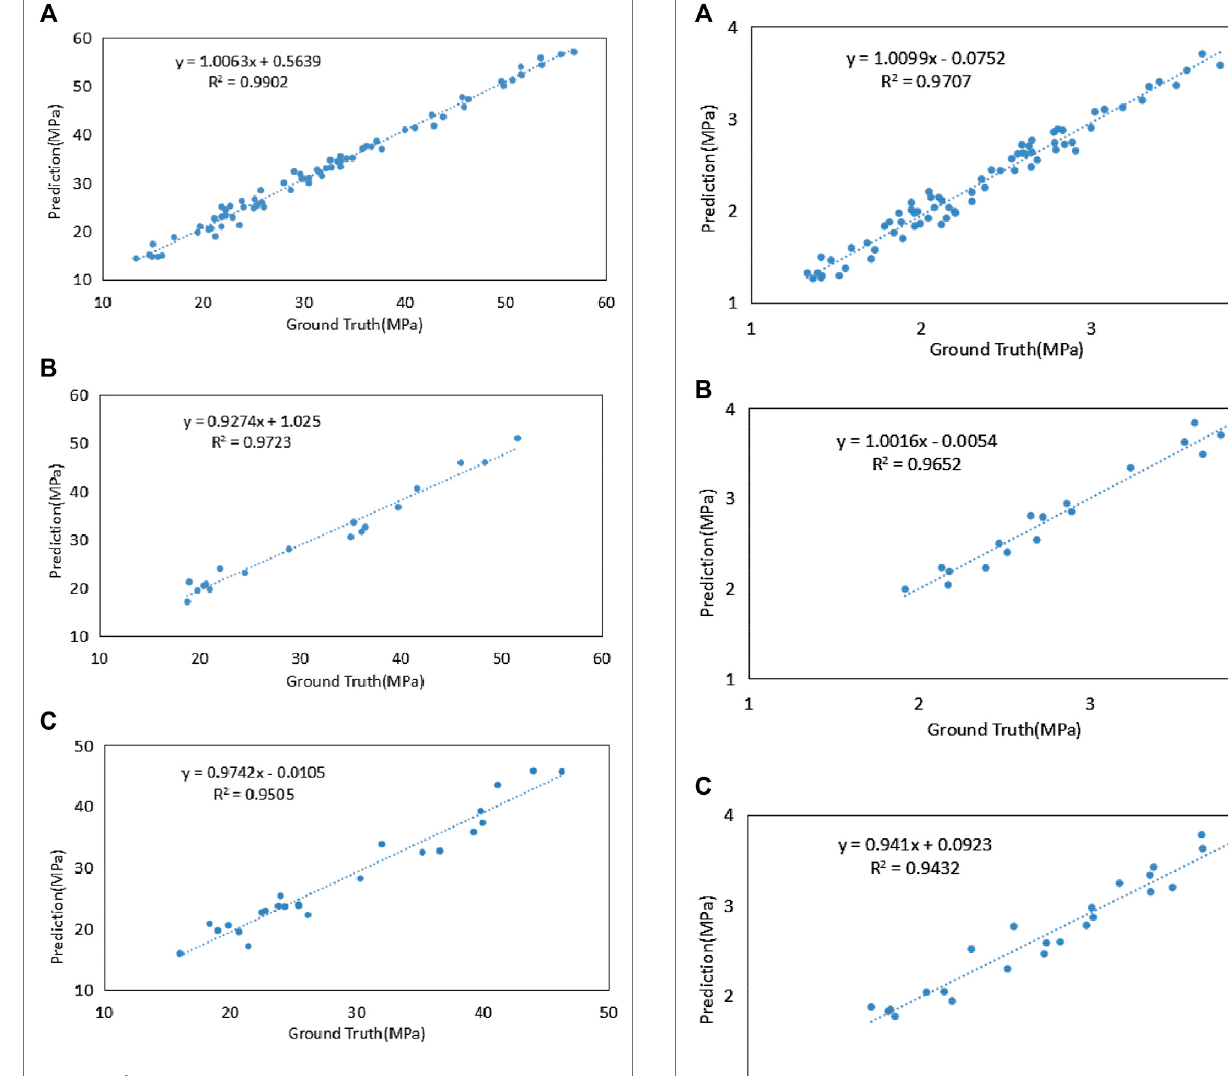
FIGURE 3 | Correlation between predicted and experimental compressive strengths: (A) training dataset, (B) validation dataset, and (C) testing dataset of ELM.